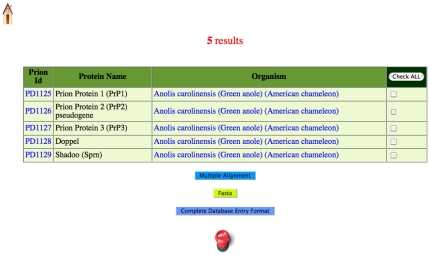
An example of the results of a keyword search, for the term ‘Anolis’ in the ‘Organism’ field.Five entries for Anolis caroliensis (a lizard), appear listed.